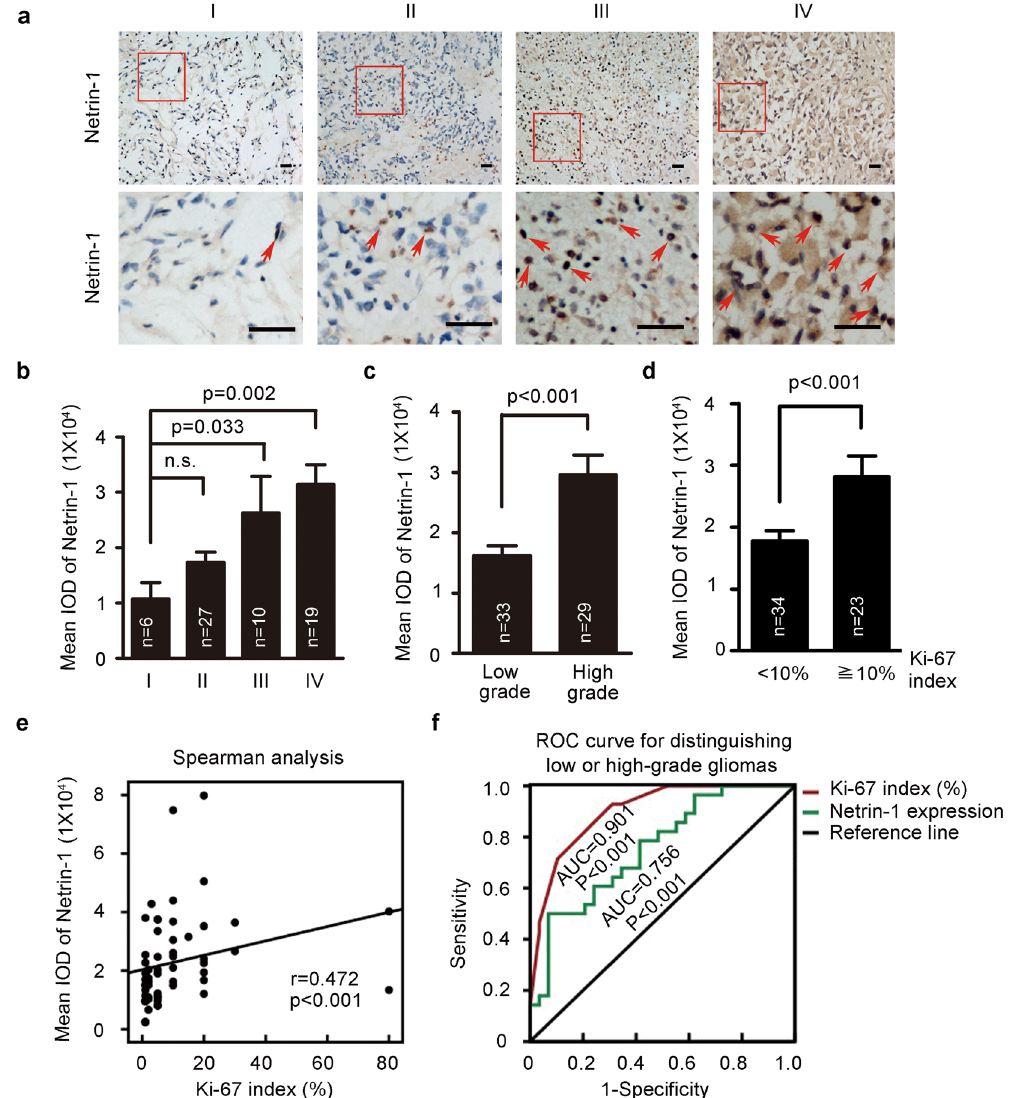
Figure 2. Elevated netrin-1 expression was positively correlated with cell proliferation in glioma tissue specimens. ( a ) Representative images of netrin-1 staining by IHC in glioma cancer sections. Boxed areas in the upper panels were magnified and are shown in the corresponding lower panels. Red arrowheads indicated examples of cells with positive netrin-1 staining. Scale bar: 50 μ m. ( b ) Relative netrin-1 expression in glioma specimens of different grades. The mean integrated optical density (IOD) of netrin-1 staining was determined using Image-Pro Plus. ( c ) Relative netrin-1 expression in low- and high-grade gliomas. The mean IOD of netrin-1 staining was determined using Image-Pro Plus. ( d ) Ki-67 expression in low- and high-grade gliomas. ( e ) Netrin-1 expression and Ki-67 index of each glioma tumor sample were plotted for the Spearman analysis. ( f ) ROC analysis showed that netrin-1 expression (AUC = 0.756, p < 0.001) and Ki-67 levels (AUC = 0.901, p < 0.001) could discriminate low-grade gliomas from high-grade gliomas. One-way ANOVA and Student’s t-test were used to test for statistical significance. The data are shown as the mean ± SEM. n.s., P >